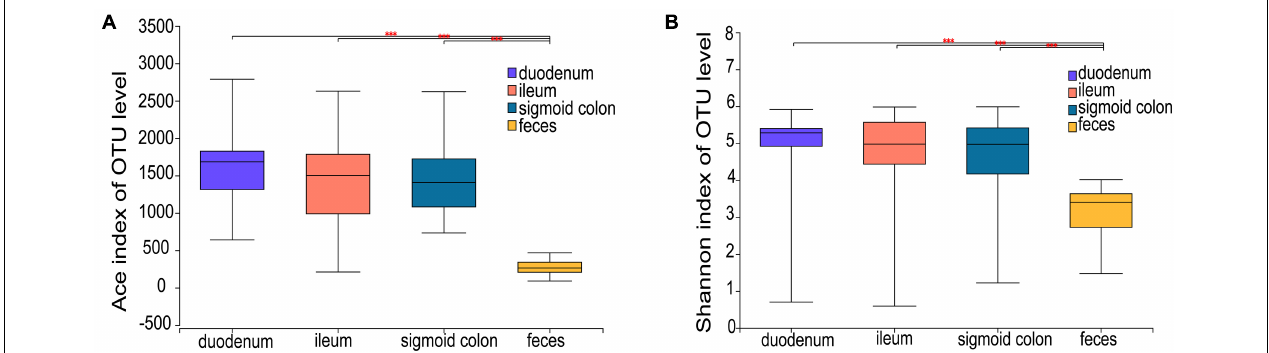
FIGURE 1 | Microbial richness and diversity of the mucosal and fecal microbiota of all subjects. (A,B) Ace richness and Shannon diversity indices of mucosal and fecal samples: the richness and diversity were significantly lower in the fecal samples compared to the mucosal samples of the duodenum, ileum, and sigmoid colon. Data are presented as mean ± standard deviation of the mean for each sample type. The differences between groups were calculated using the Wilcoxon rank-sum test. *** P <